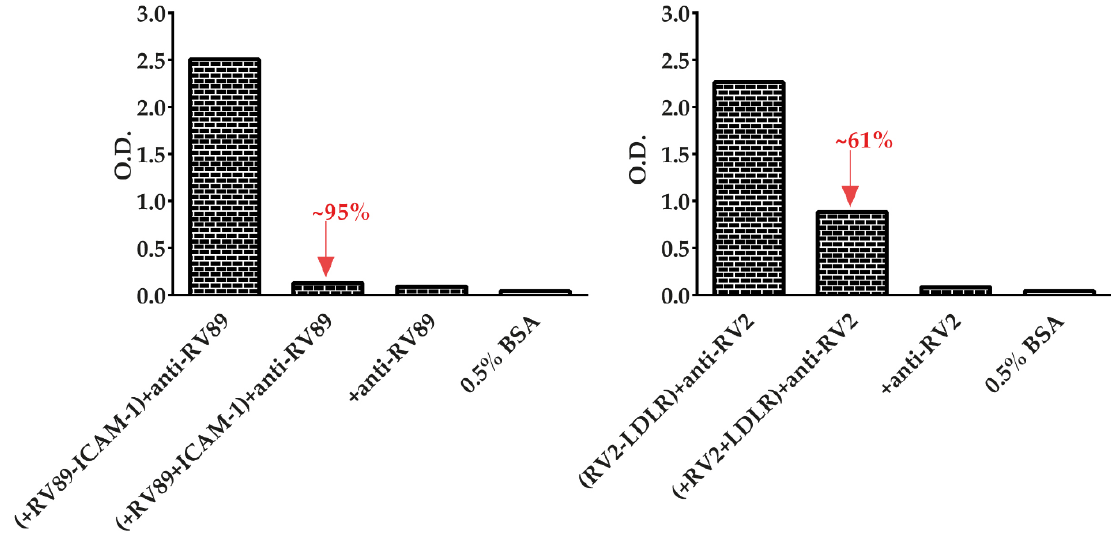
Figure 7. Auto-inhibition of the binding of major group RV89 and minor group RV2 to their receptors. Binding of RV89 to ICAM-1 ( left ) and of RV2 to LDLR ( right ) without (first column) or with (second column) pre-incubation with the receptor plus controls in which virus and receptor (third column) or virus, receptor and detection antibodies (fourth column) were omitted, reported as mean optical density (i.e., O.D.) values (y-axes). The percentage inhibitions of RV89 and RV2 binding produced by pre-incubation with receptors are indicated in red. The results are means of duplicate determinations with a variation of less than 10%. Inhibition experiments with soluble receptors were performed two times.